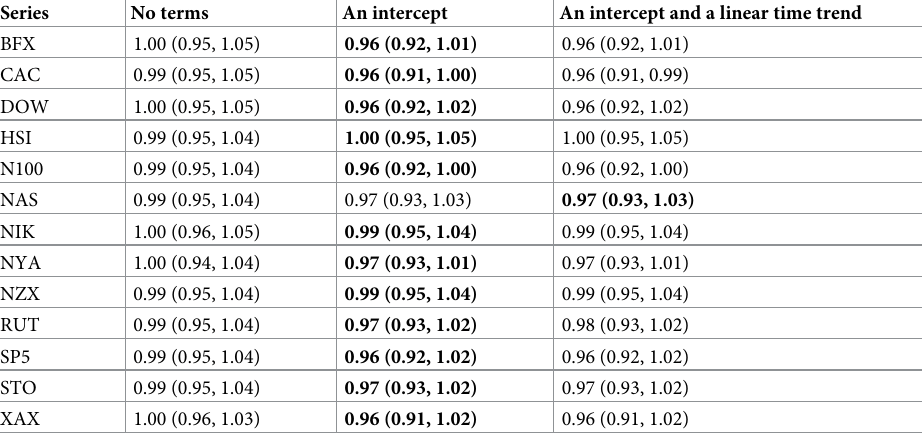
Table 2. Estimates of d for the SILVER differential. Sample ending in Dec. 2020.